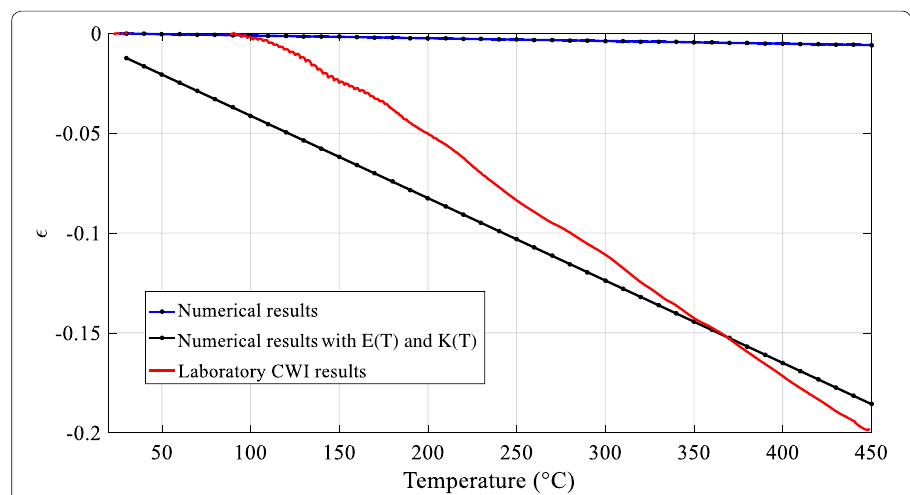
Fig. 14 Comparison of laboratory CWI measurements during the first cycle (red line) with the simulated CWI measurements obtained without (blue line) and with (black line) introduction of a dependency with temperature of the bulk modulus K and of the Young’s modulus E . Relative time delays ε are calculated from the stretching technique. A linear regression is fitted to the measurements. The slope of the linear regression fitted to the simulated CWI results is s 1 0.13 10 − 4 without introduction of the temperature dependency = − · and it is – 4.1 10 − 4 when the dependency is added to the ·